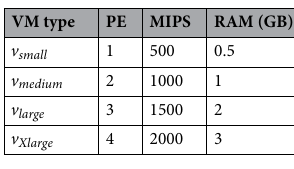
Table 2. VM configuration.